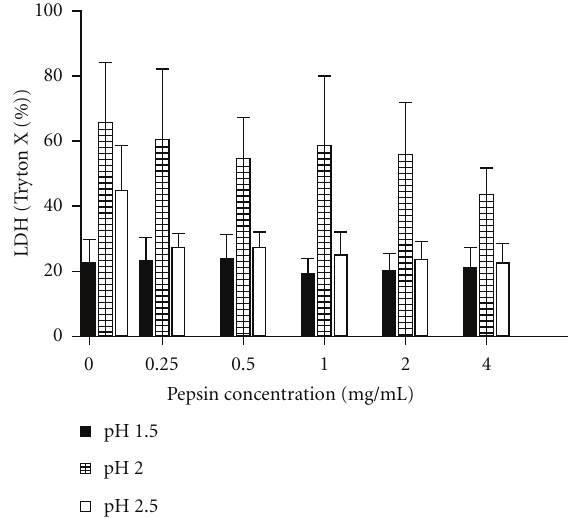
Figure 1: Exposure of cells for 5 minutes induced more cytotoxicity as measured by LDH after 20 hours incubation at pH 2.0 (mean (SEM) 57% ± 5.77%) compared to both pH 1.5 and pH 2.5 (22% ± 2.17%, and 28% ± 2.81%, resp., both P < 0 . 01). LDH release was pH-dependent ( P < 0 . 01). There was a trend for a pepsin e ff ect ( P = 0 . 078), with lower LDH release with pepsin at all concentrations compared to no pepsin, independent of pH